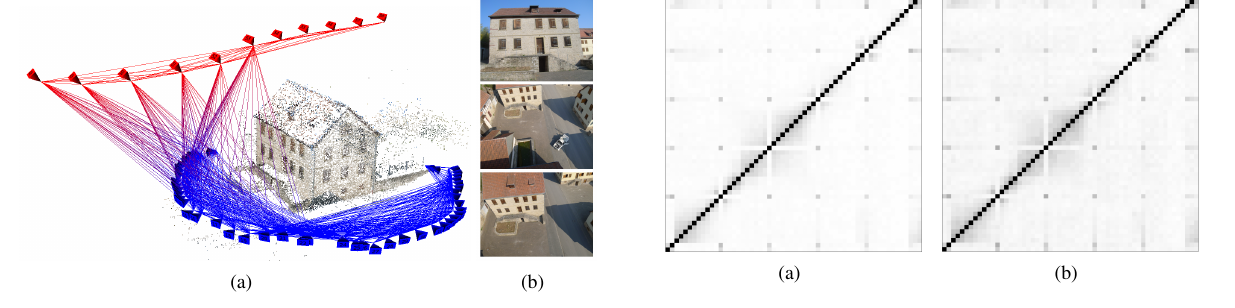
Figure 3. Image set House containing 59 terrestrial and aerial images with wide baselines between them. The obtained camera poses are shown as pyramids on the left hand side. Lines connect images which have at least ten points in common. The images of one of the triplets used to connect terrestrial and aerial images are shown on the right hand side.